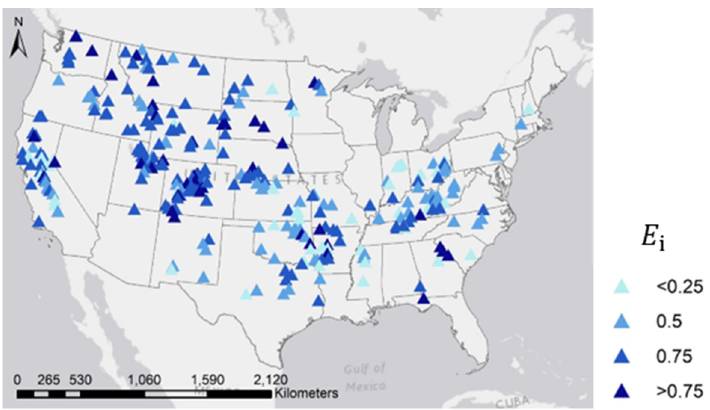
Figure 3. The efficiency metrics of reservoir.